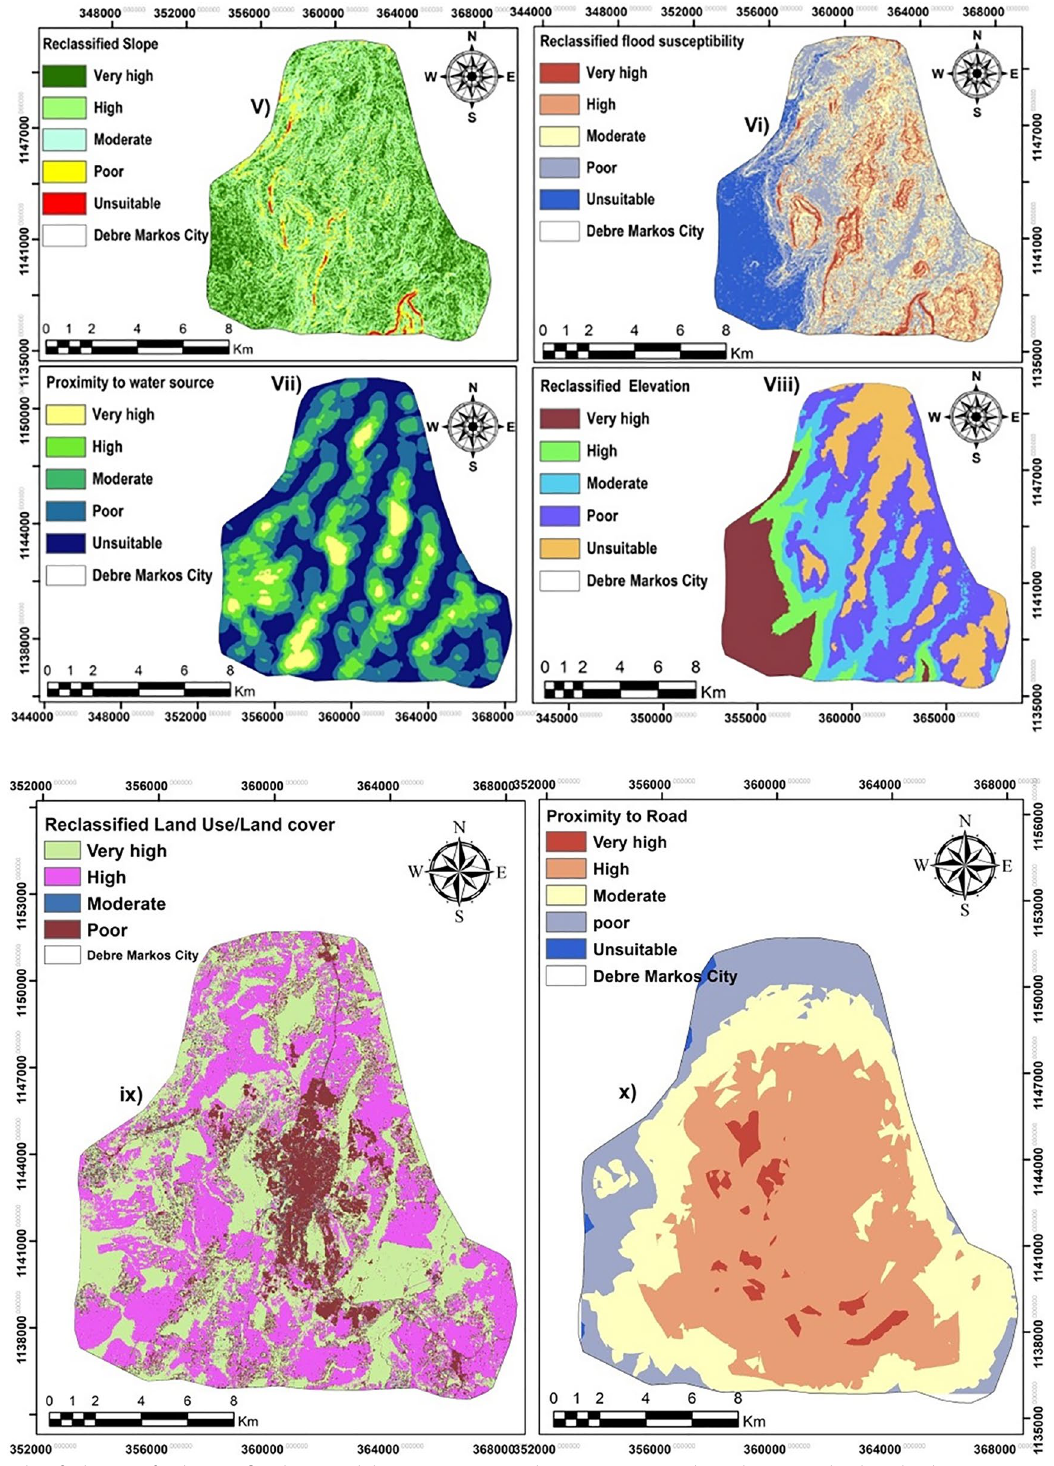
Fig. 9 Reclassified maps of v slope, vi flood susceptibility, vii proximity to the water source and viii elevation ix land use land cover map x proximity to the